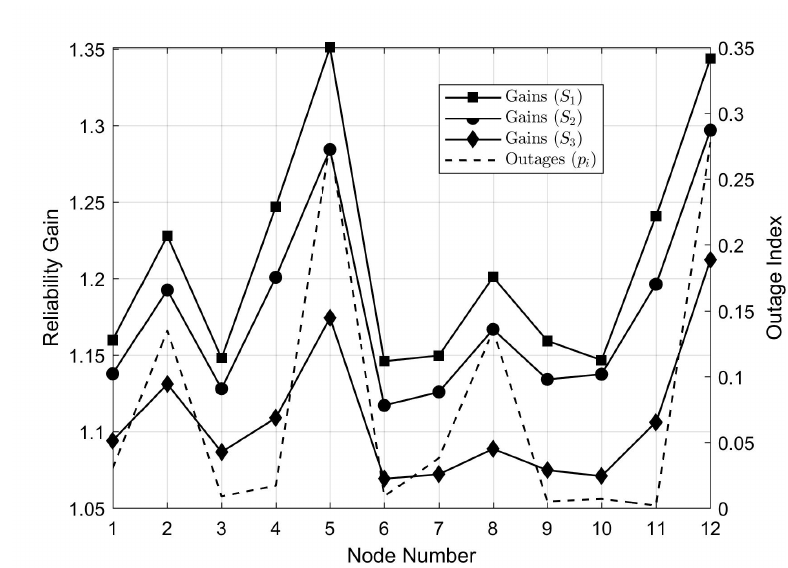
Figure 9. Node reliability gains plotted together with respective DEC